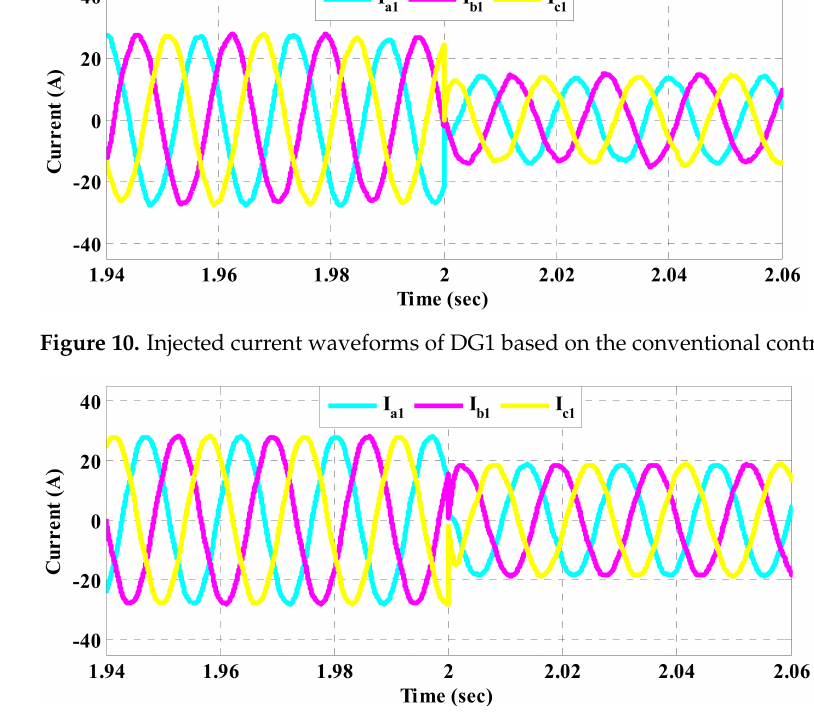
Figure 11. Injected current waveforms of DG1 based on the proposed control